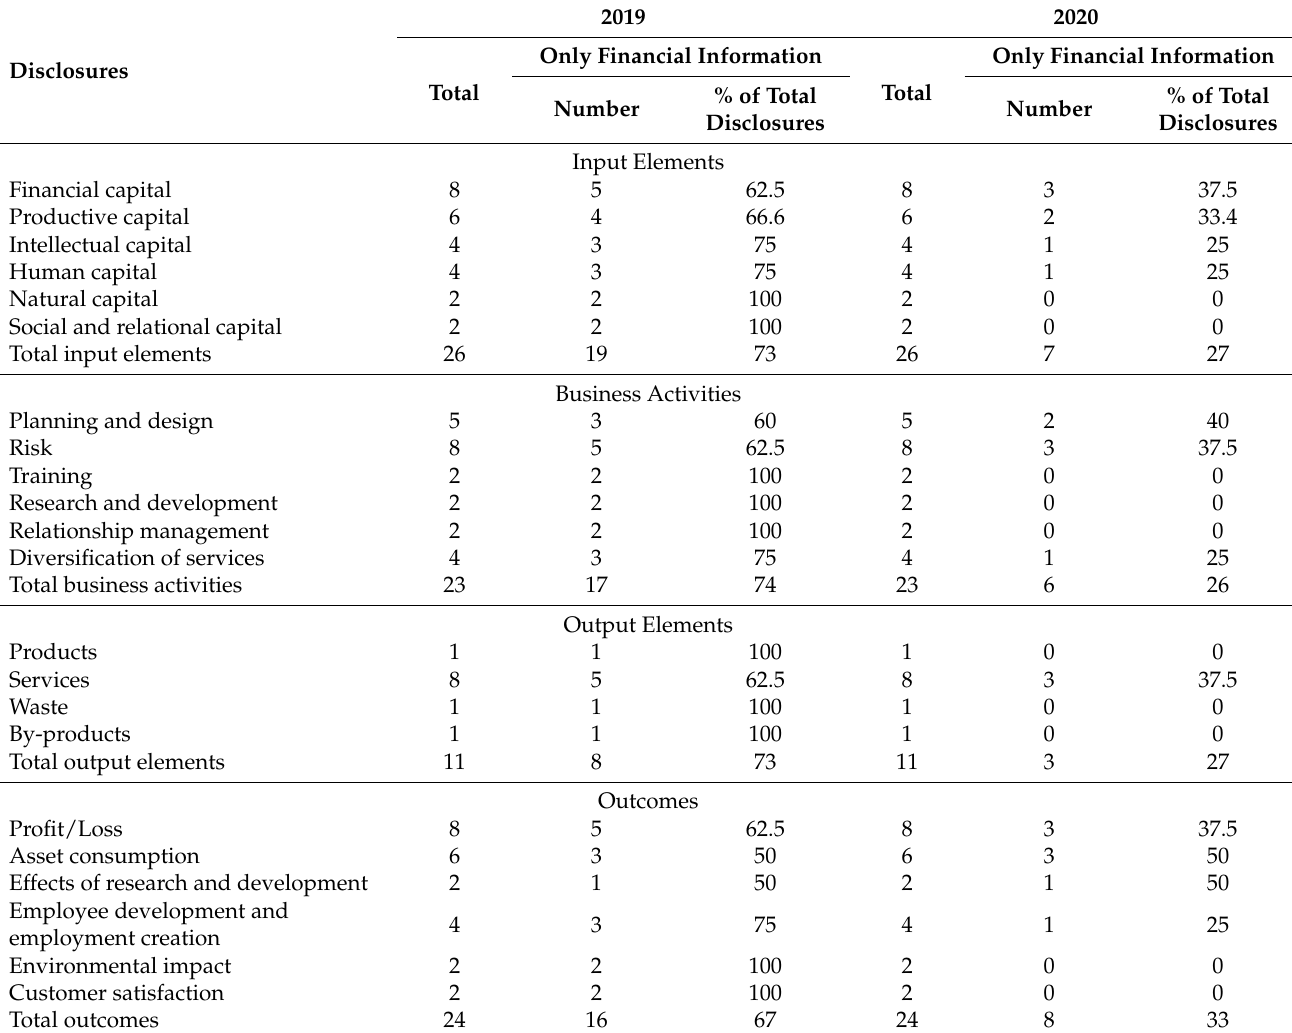
Table 4. The number of disclosures on components of the business model of companies in the energy sector—only financial